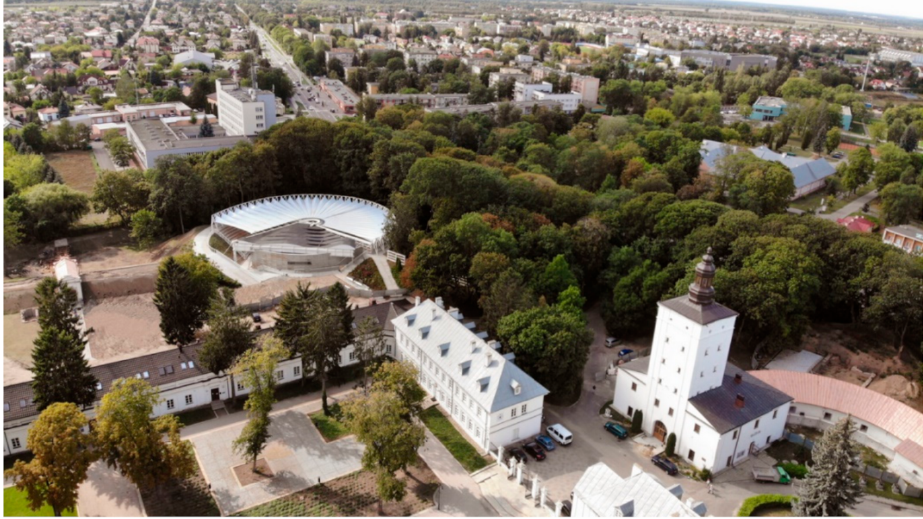
Figure 1. Cultural environment of the odeon in Biała Podlaska, aerial view. Photo: Stanisław Butelski